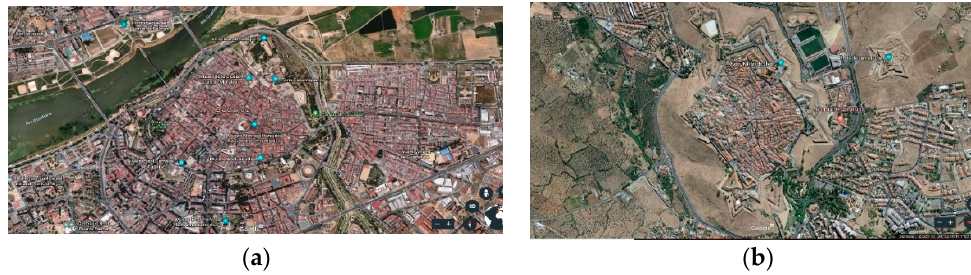
Figure 1. View through Google Earth. ( a ) View of the Badajoz wall through Google Earth. ( b ) View of the Elvas wall through Google